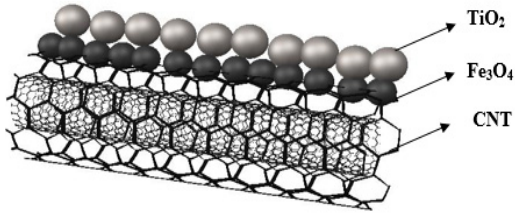
Fig. 2. Schematic image of TiO 2 /Fe 3 O 4 /MWCNT nanocomposite